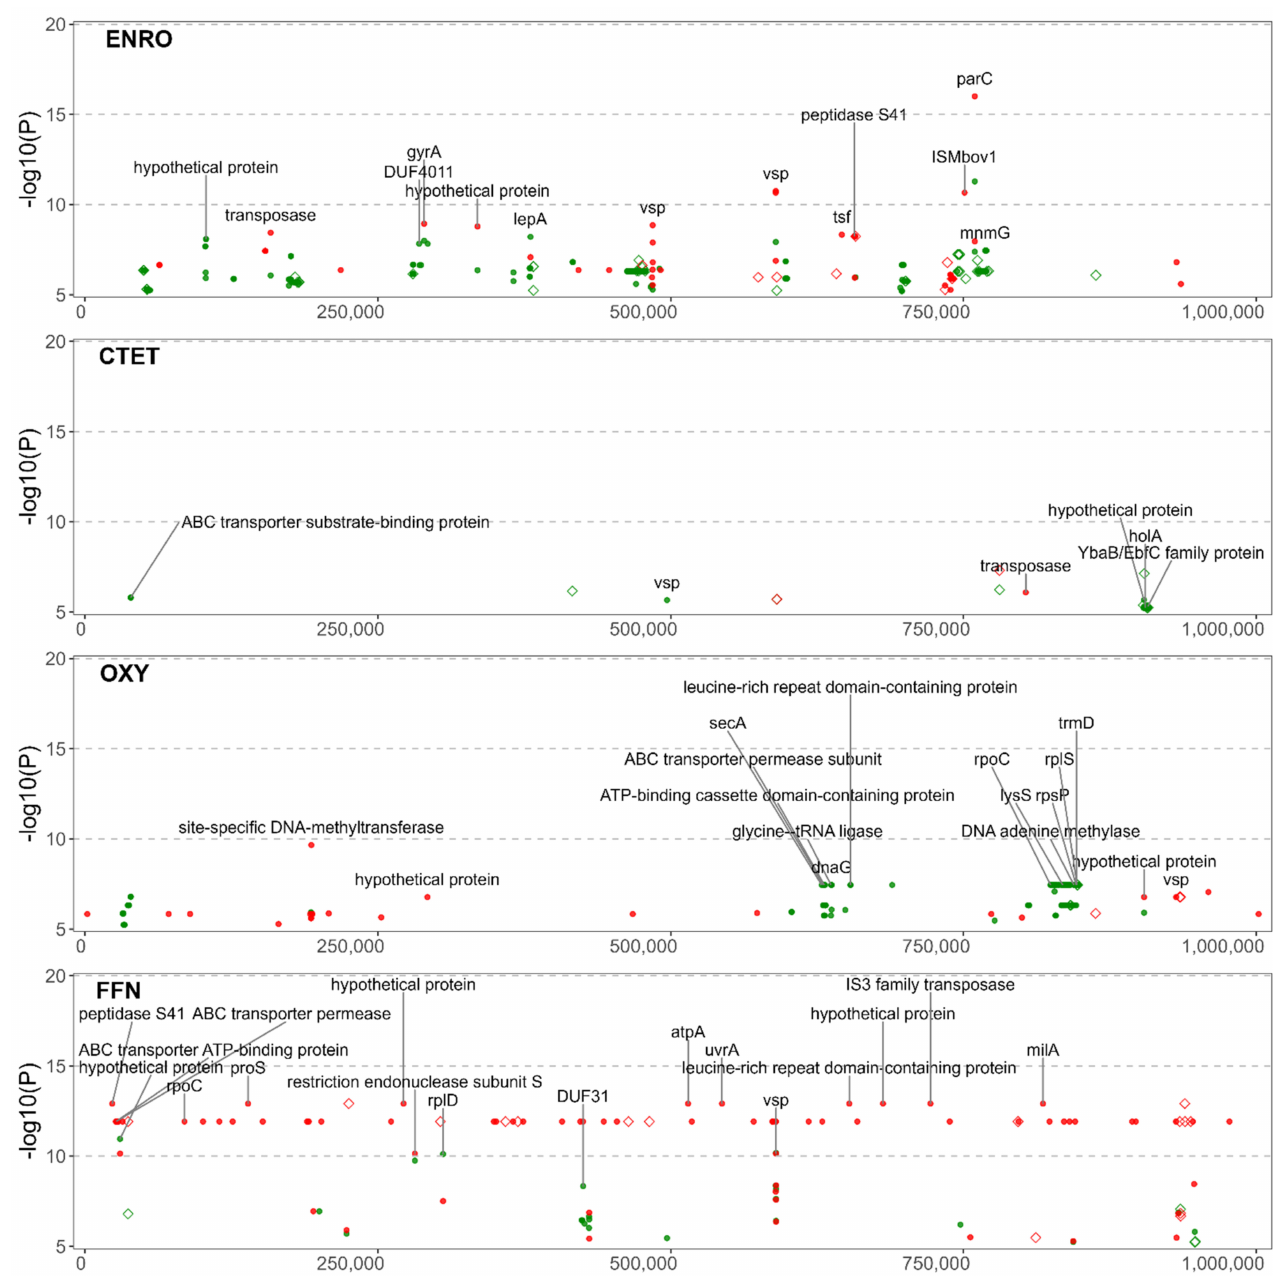
Figure 2. Manhattan plots of variants for enrofloxacin, chlortetracycline, oxytetracycline, and flor- fenicol resistance. Variants are colour-coded, with fixed effects linear model (green) and linear mixed model (red). The y -axis represents the level of statistical significance [ − log10 ( p -value)] with position of the nucleotide variant on the x -axis. Significant NVs identified within coding regions are represented with a dot, while significant NVs within non-coding regions are denoted with a hollow